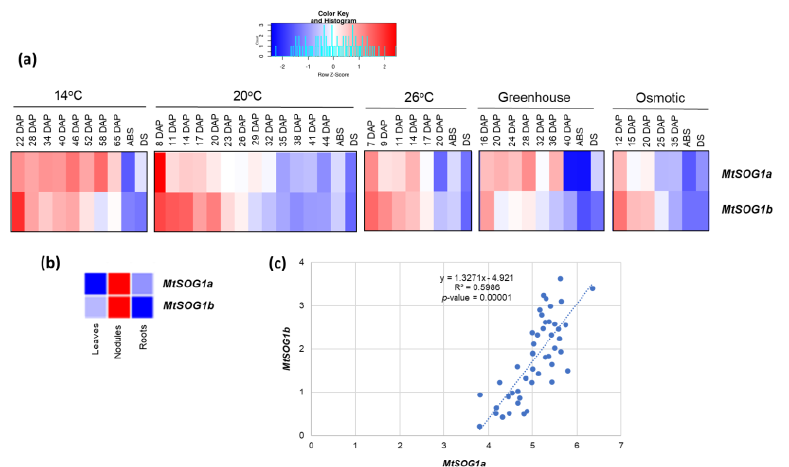
Figure 2. ( a ) Expression profiles of the MtSOG1a (Medtr5g053430) and MtSOG1b (Medtr1g093680) genes in M. truncatula . Data were collected from http://bar.utoronto.ca/, accessed on 19 March 2022 and heatmaps were generated using the Shinyheatmap (http://shinyheatmap.com, accessed on 19 March 2022). ( b ) Expression profiles in roots, leaves, and nodules of 4-week-old plants grown under greenhouse conditions. ( c ) Correlation analysis of MtSOG1a and MtSOG1b gene expression values. In the case of soybean, four GmSOG1 homologues were identified: GmSOG1a (Glyma.02G100200), GmSOG1b (Glyma.20G185800), GmSOG1c (Glyma.10G204700), and GmSOG1d (Glyma.01G088200). Data available on different plant tissues (roots, nodules, leaves, flowers, pods, SAM) and seed maturation stages (given as days after flowering,